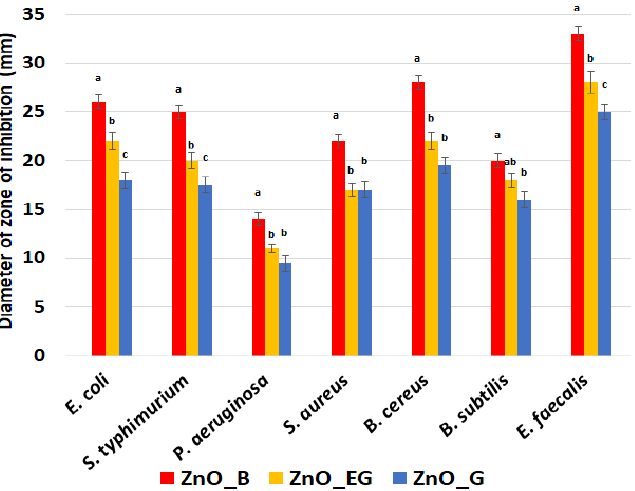
Figure 12. Growth inhibition diameters (mm) measured for each bacterial strains in the presence of ZnO NPs. Different small letters indicates statistically significant differences between films ( p < 0.05).